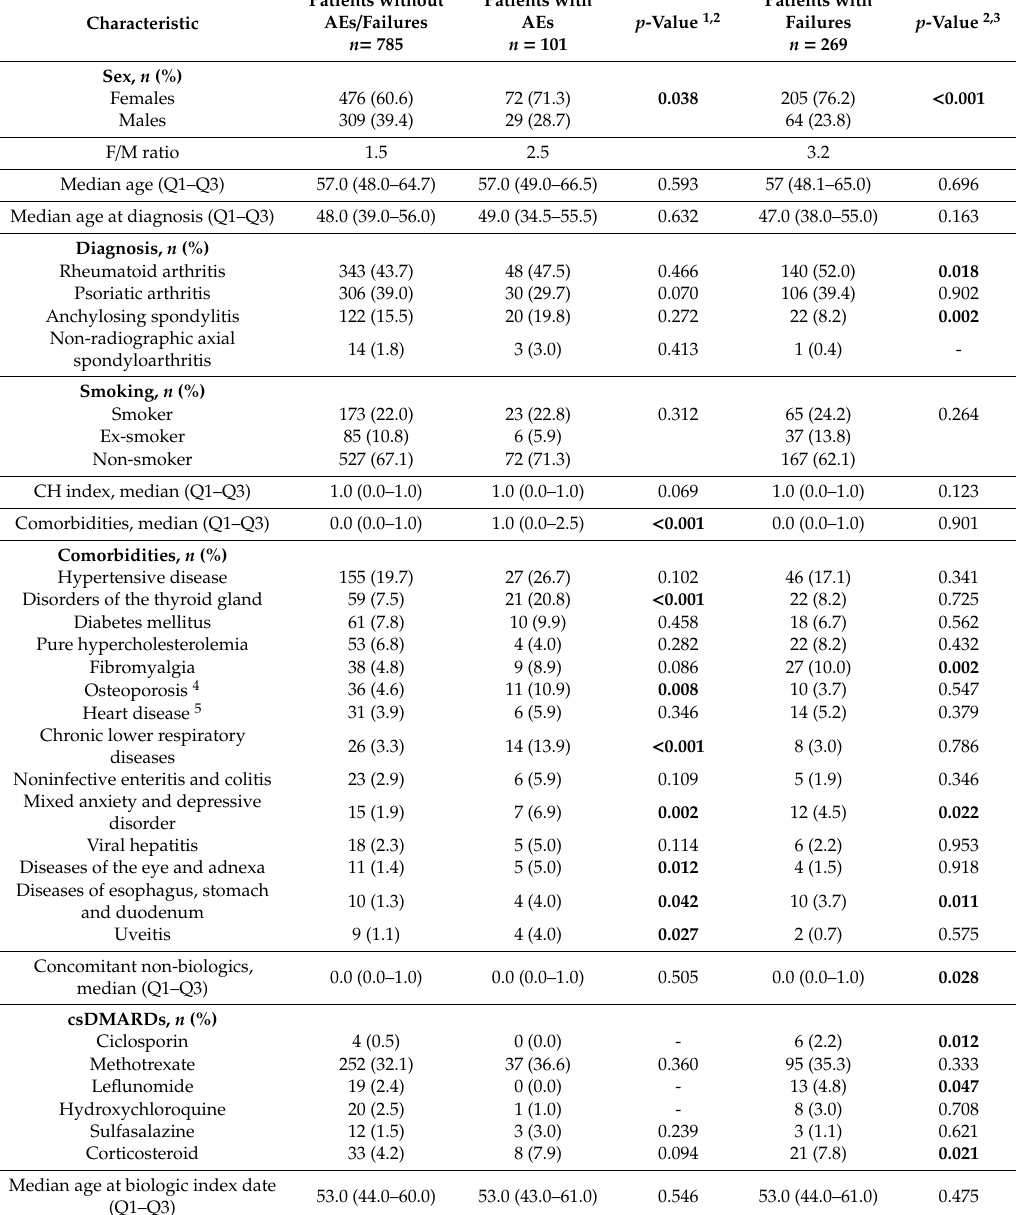
Table 1. Characteristics of patients treated with biologic disease-modifying antirheumatic drugs (bDMARDs) during the period